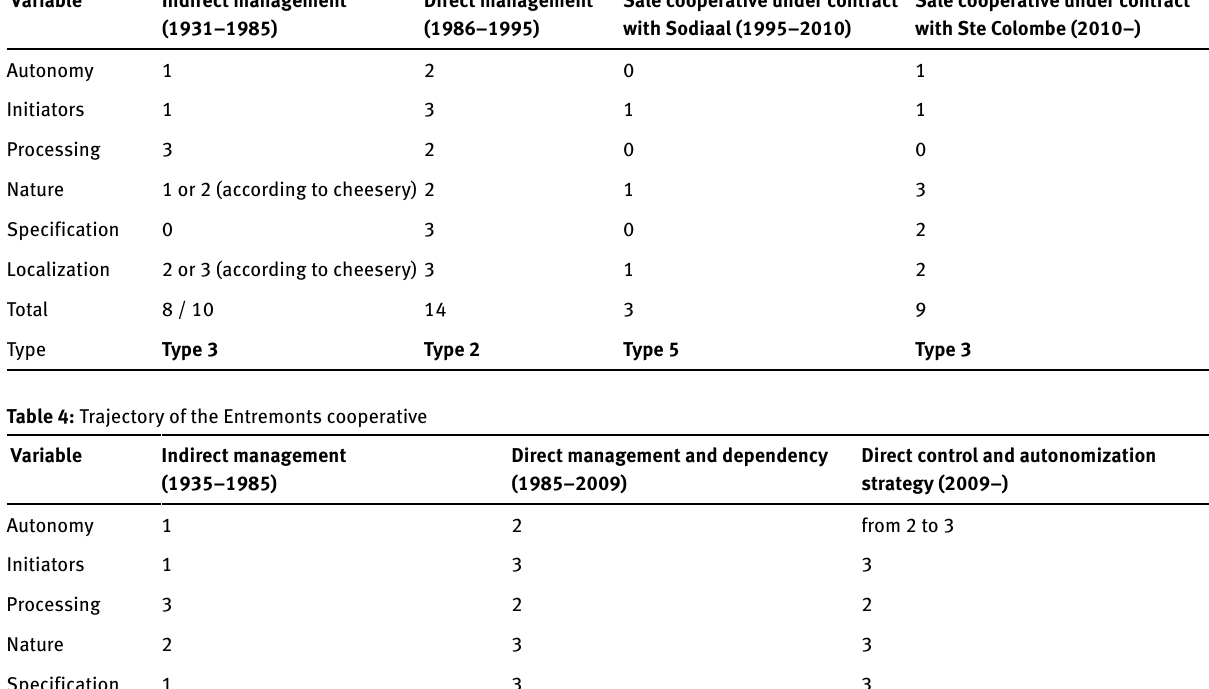
Table 3: Trajectory of the Miribel cooperative Variable